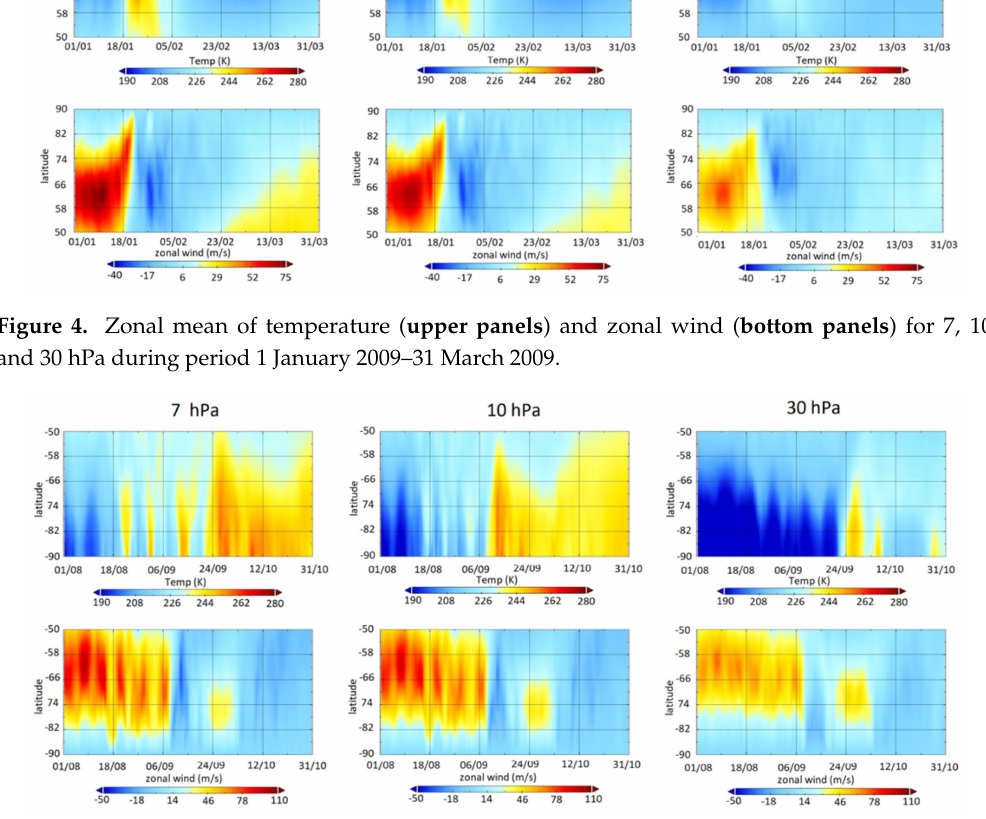
Figure 5. The same as Figure 4 but for the SH and period 1 August 2002–30 October 2002.